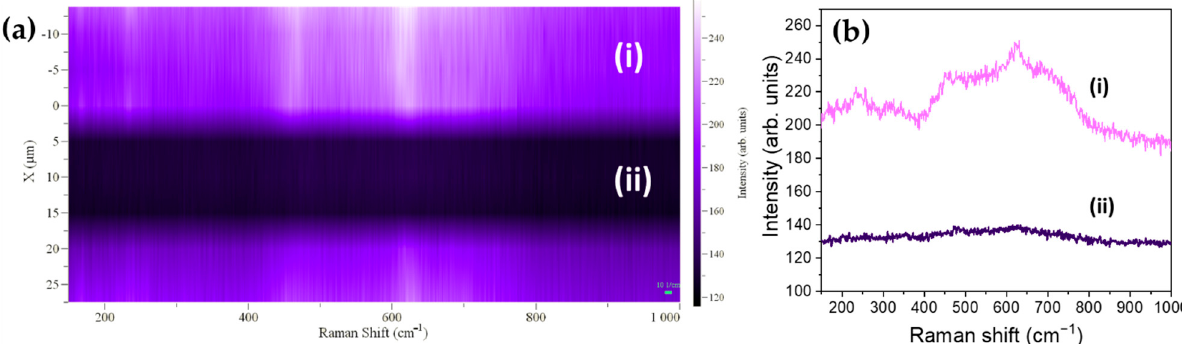
Figure 5. ( a ) Line patterning induced by UV irradiation. Two clear different zones can be observed corresponding to (i) SnO 2 obtained after UV irradiation and (ii) SnO in the non-irradiated region. ( b ) Raman spectra acquired with the UV laser on regions (i) and (ii). Mapping in ( a ) was obtained by scanning both regions (irradiated and non-irradiated) with 0.1·I 0 .